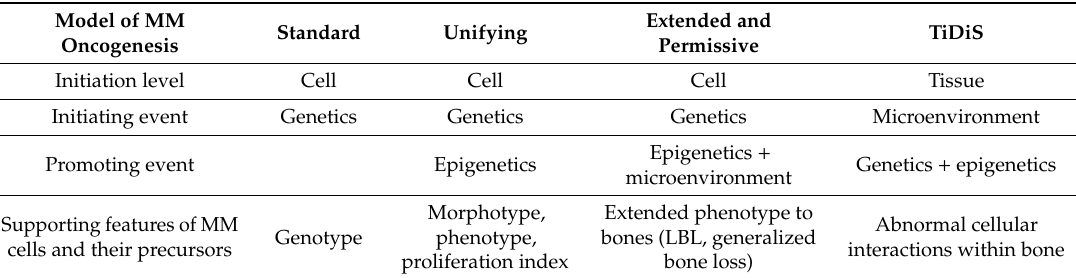
Table 2. Di ff erent models of multiple myeloma (MM) oncogenesis according to their initiating and promoting